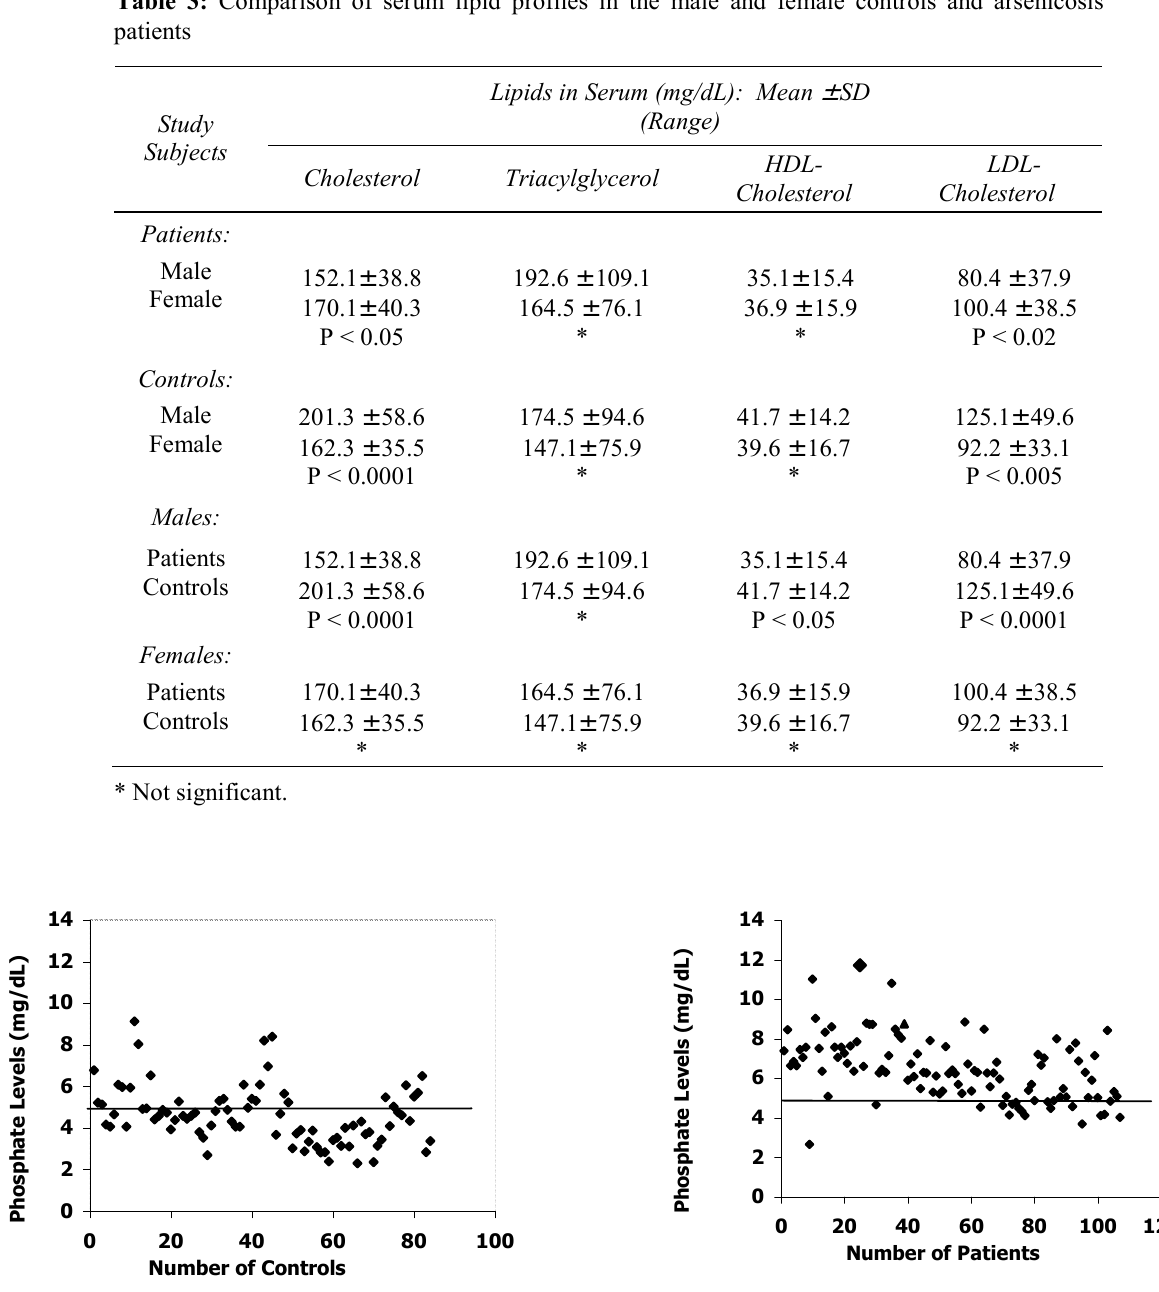
Figure 2: Levels of inorganic phosphate in the serum of the controls and arsenicosis patients. Each symbol indicates the value in one subject and the horizontal line shows the upper limit for normal values (4.97